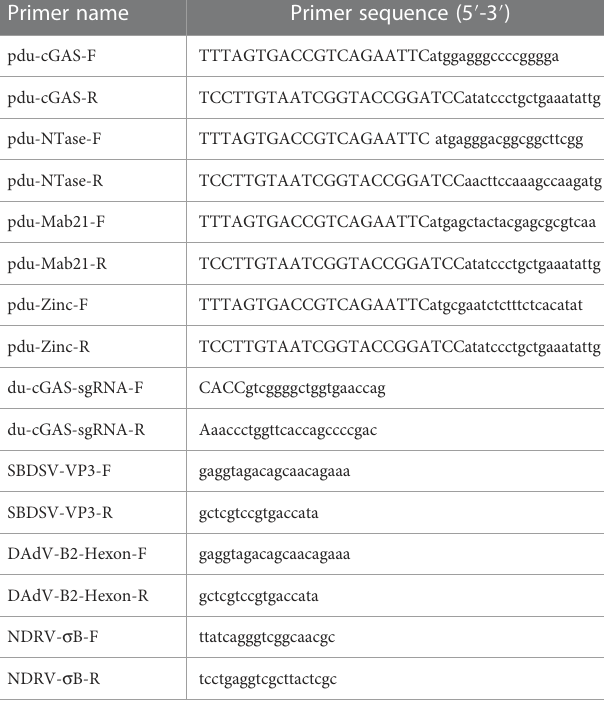
TABLE 1 Primer sequences used in this